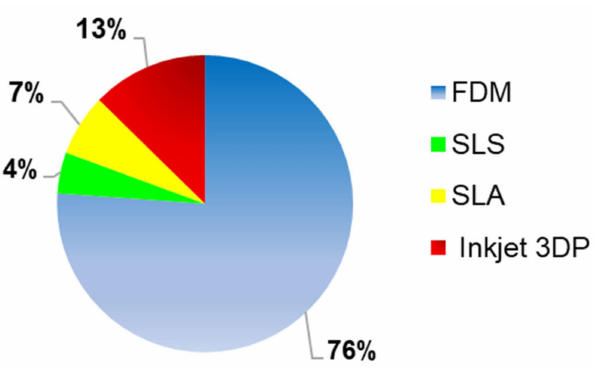
Figure 5. Quantification of the four 3DP techniques used in the articles included in the systematic review, (1) FDM (purple), (2) SLS (green), (3) SLA (yellow) and (4) inkjet 3DP